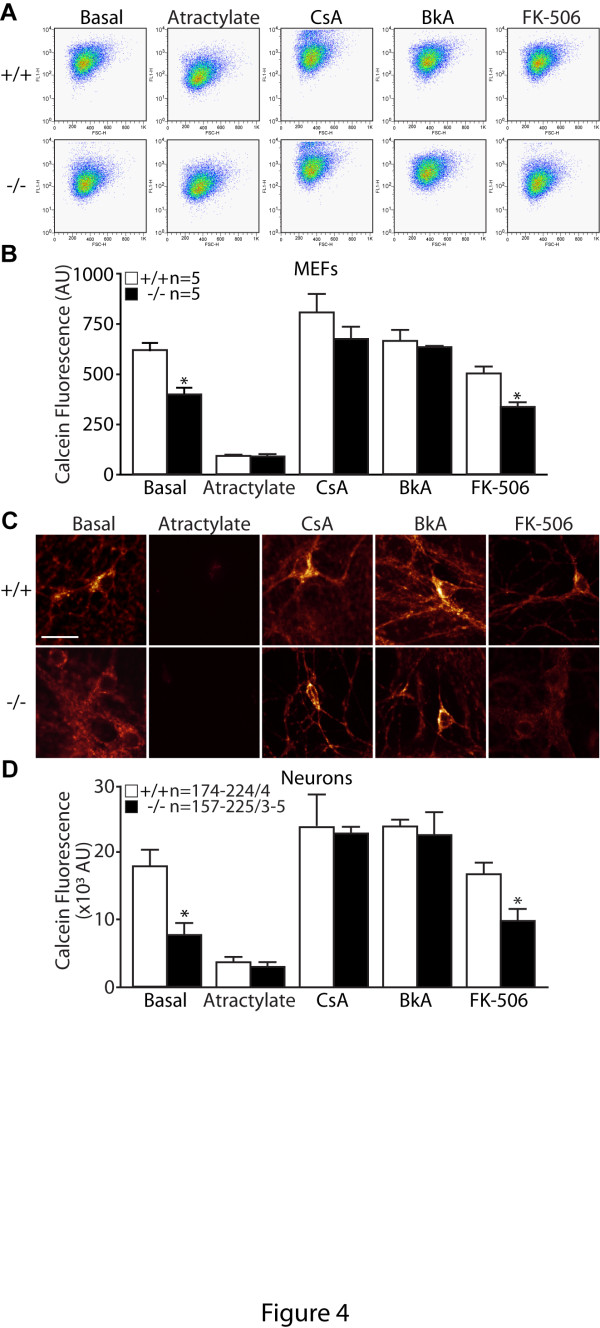
Effects of mPTP agonists and inhibitors on its opening inPINK1−/− cells. A. Representative flow cytometry dot plots showing calcein fluorescence in PINK1−/− and +/+ cells treated with calcein-AM (1 μM) and Co2+ (1 mM) under basal conditions or following various treatment, such as in presence of the mPTP agonist atractylate (20 μM), the mPTP inhibitors Cyclosporine A (CsA, 1 μM) or Bongkrekic acid (BkA, 10 μM), or the calcineurin inhibitor FK-506 (5 μM). B. The bar graph shows quantification of calcein fluorescence after FACS analysis following various treatment, such as atractylate (20 μM), CsA (1 μM), BkA (10 μM), or FK-506 (5 μM). The number shown in the panel indicates the number of independent experiments performed. C. Representative images showing calcein fluorescence in PINK1−/− and +/+ cortical neurons incubated with calcein-AM (1 μM) and Co2+ (1 mM) under basal conditions or in the presence of atractylate (20 μM), CsA (1 μM), BkA (10 μM) or FK-506 (5 μM). D. Quantification of calcein fluorescence in PINK1−/− and +/+ neurons following various treatment with atractylate (20 μM), CsA (1 μM) or BkA (10 μM) or FK-506 (5 μM). The numbers shown in panels indicate the number of cells used (left) and the number of independent experiments performed (right) in the study. All data are expressed as mean ± SEM. * p < 0.05.